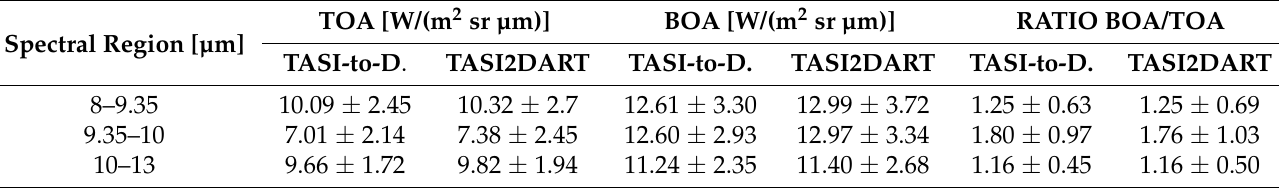
Table 3. TOA and BOA mean values for the considered spectral regions. In the TASI-to-D. column are the values for the TASI-to-DART dataset, in the TASI2DART column are the mean values and standard deviations for the generated signatures. The TASI-to-DART dataset is composed of about 800 spectra, while TASI2DART of 198. Spectral Region